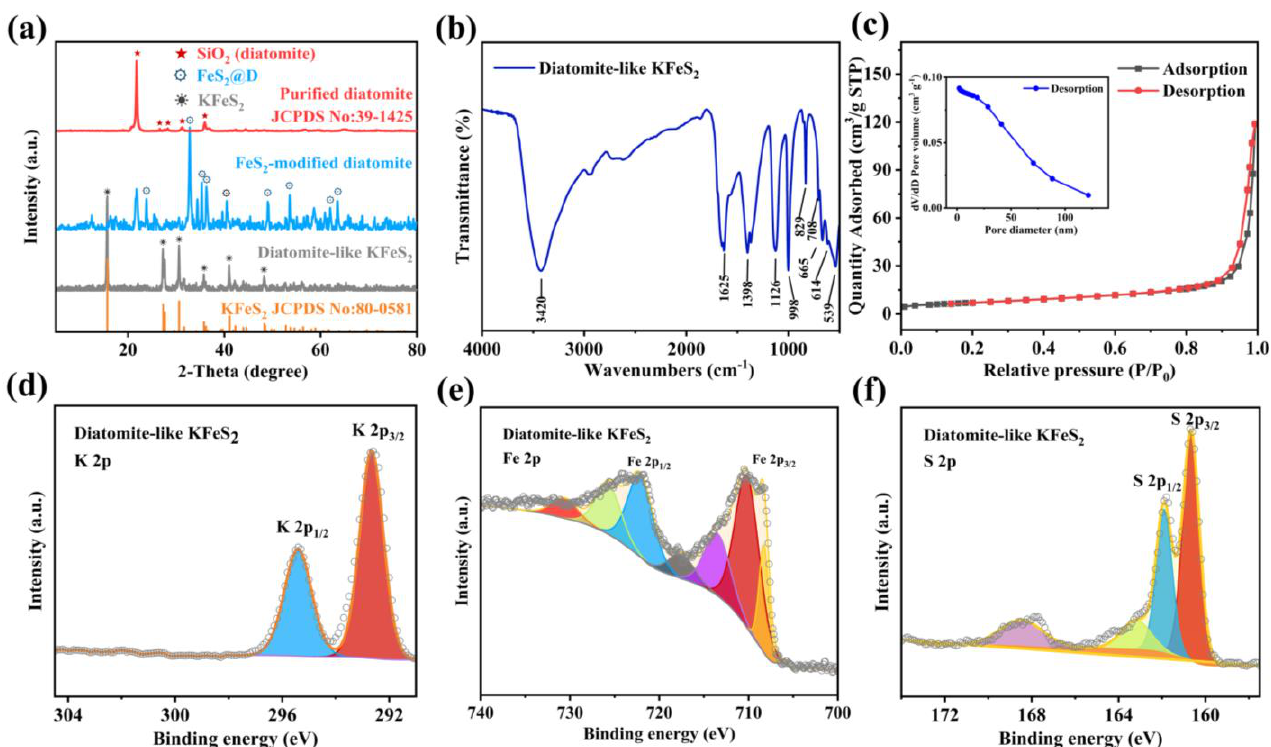
Figure 2. ( a ) XRD patterns of purified diatomite, KFeS 2 with diatomite morphology, and FeS 2 -modified diatomite; ( b ) FT-IR spectra of diatomite-like KFeS 2 in the range of 500–4000 cm − 1 ; ( c ) N 2 adsorption–desorption isotherms and the corresponding pore size distribution of the diatomite- like KFeS 2 ; high-resolution XPS spectra of K 2p, Fe 2p, and S 2p of the diatomite-like KFeS 2 ( d – f ),